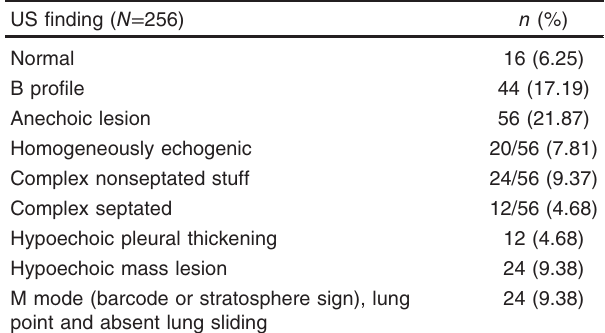
Table 5 Diagnostic performance of chest radiography regarding the final